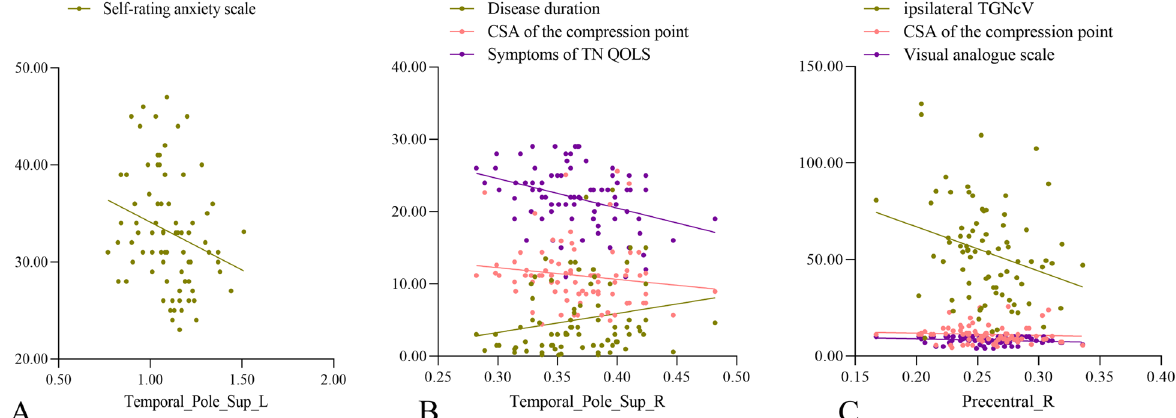
Fig. 4 Correlations between the clinical parameters and brain regions in which the GMV changed in patients with CTN. ( A ) The GMV of TPOsup_L was negatively correlated with self-rating anxiety scale ( P 0.005, r –0.341), ( B ) The GMV of TPOsup_R was positively correlated with disease = = duration (years) ( P 0.030, r 0.245) and negatively correlated with the CSA of compression point ( P = = QOLS ( P 0.002, r –0.336). ( C ) The GMV of precentral_R was negatively correlated with the ipsilatreal TGNcV ( P = = the compression point ( P 0.041, r –0.231), and VAS ( P < 0.025, r –0.252). GMV, gray matter volume; CTN, classical trigeminal neuralgia; CSA, = = = cross-sectional area; TN QOLS, quality-of-life score of patients with trigeminal neuralgia; TGNcV, volume of trigeminal nerve cisternal